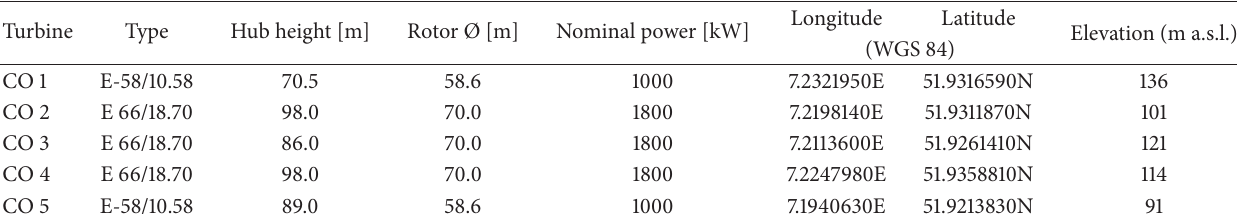
Table 5: Coordinates and data of the wind turbines at the site Coesfeld .